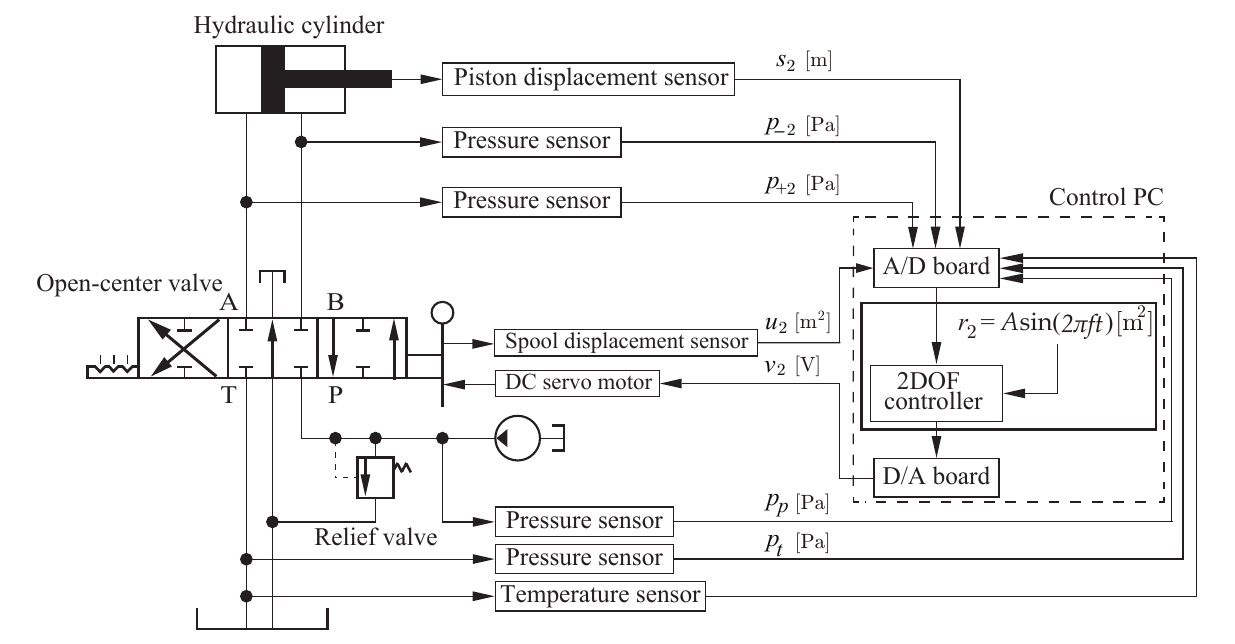
Figure 6. System